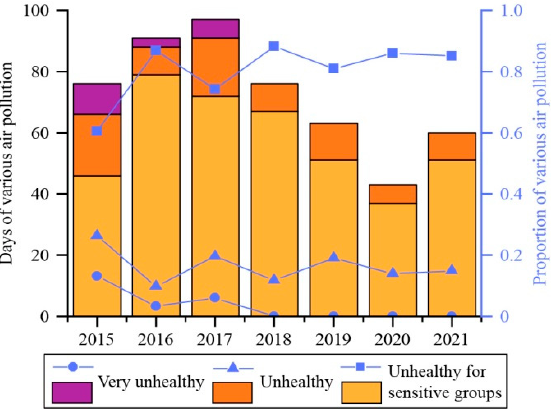
Figure 6. Annual days and proportions of various severity of air pollution from 2015 to 2021.